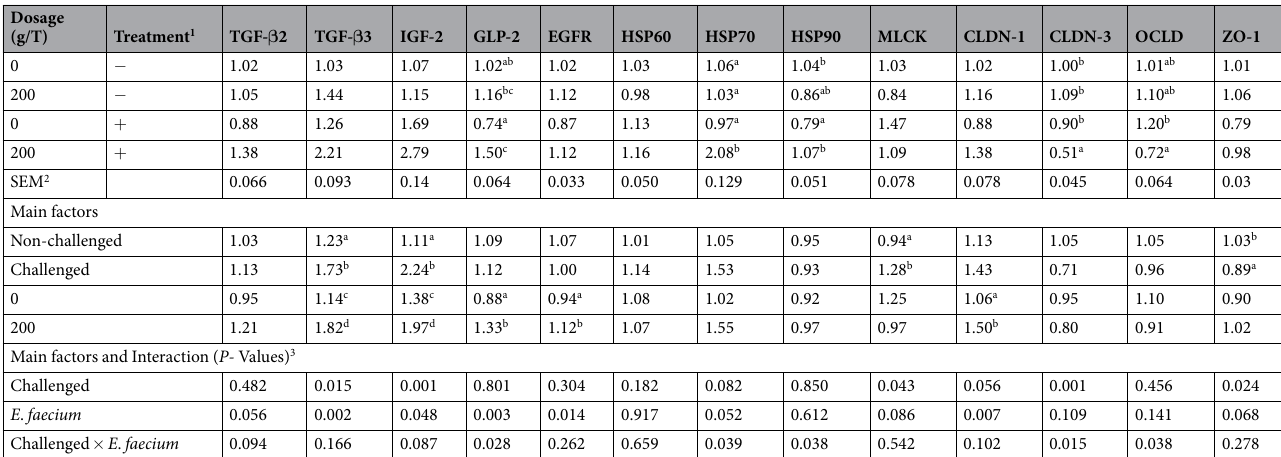
Table 3. Effect of dietary E . faecium 11181 on the mRNA expression of growth factors, heat-shock proteins, and tight-junction proteins (on d 26, 7 DPI) in the jejunum of broiler chickens challenged with NE. a,b,c,d Means in the same column without common superscripts differ significantly (P < 0.05). 1 Co-challenged with Eimeria spp. and C. perfringens ; -, without NE challenge; + , with NE challenge. 2 SEM, standard error of the mean. 3 P -value represents the main effect of the diet, the main effect of NE challenge, and the interaction between the dietary treatments and NE